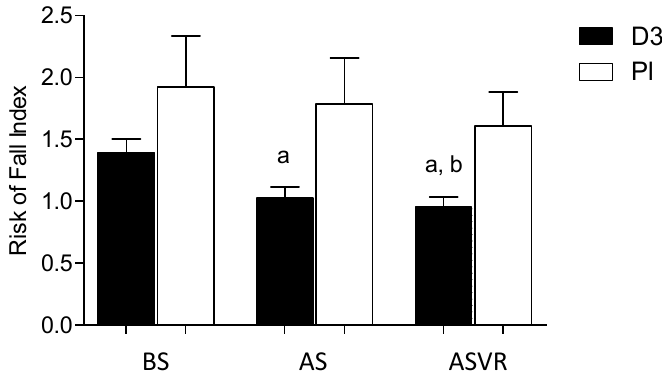
Figure 3. Vitamin D supplementation reduced the risk of falls of patients before anterior cervical interbody fusion (ACIF) surgery. The data are presented as the means and standard deviations (SDs). a, p < 0.05, significantly different compared with BS and b, p < 0.05, significantly different compared with Pl-ASVR.